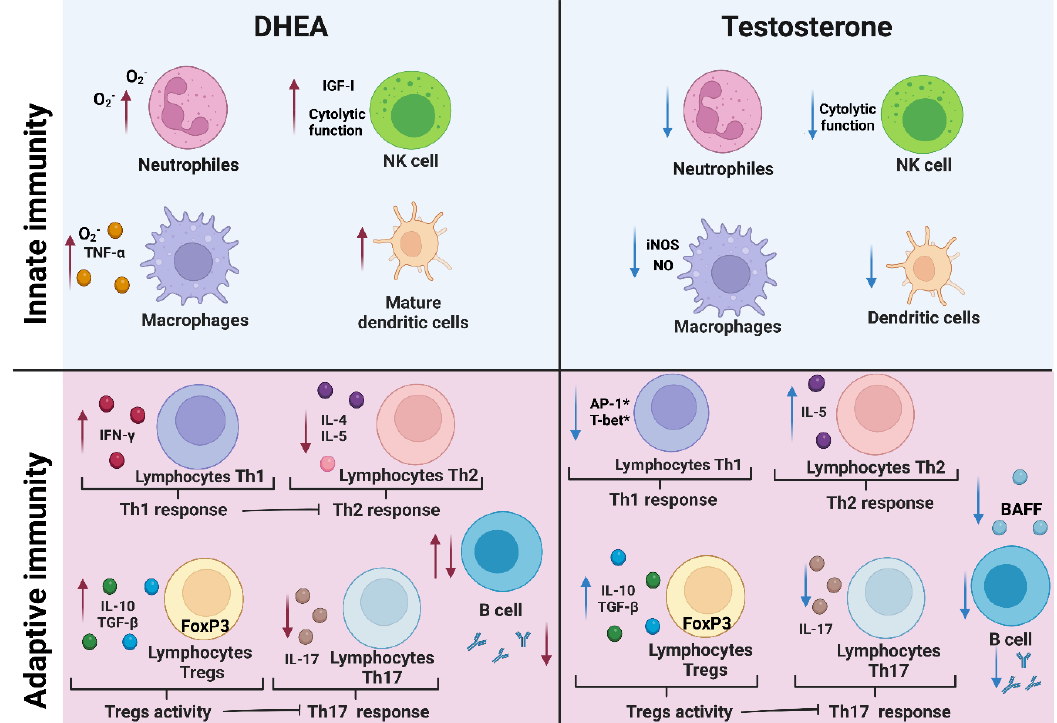
Figure 4. Effect of DHEA and testosterone on cells of the innate and adaptive immune response. Androgens modulate the proliferation of immune cells, the concentration of cytokines and the expression of transcription factors that modulate the immune response. The effects of DHEA are represented by red arrows, and those of testosterone are represented by blue arrows. The asterisk (*) indicates transcription factors probably involved in the mechanism of action. During the innate immune response, DHEA increases O 2 − synthesis in neutrophils and macrophages, and the cytotoxic activity of NK cells by enhancing the secretion of insulin-like growth factor-I (IGF-1). Furthermore, DHEA promotes the maturation of dendritic cells. In contrast, testosterone decreases neutrophil proliferation, NK-cell cytolytic activity, and macrophage nitric oxide (NO) synthesis by decreasing iNOS expression and dendritic cell proliferation.